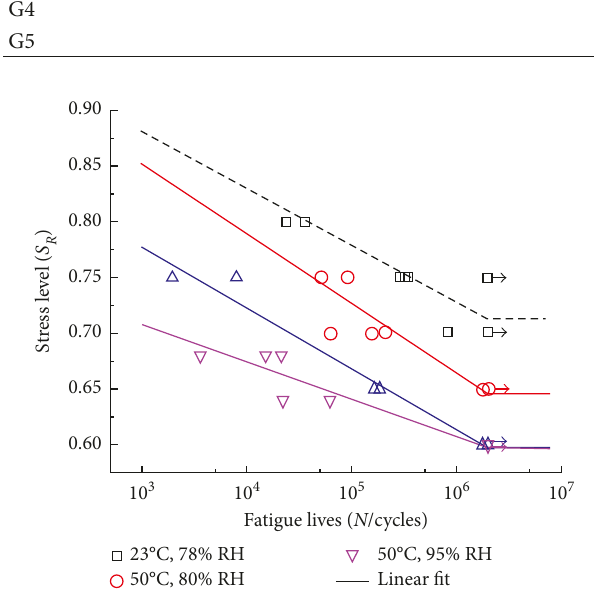
Figure 3: Experimental S environments and cyclic loads.